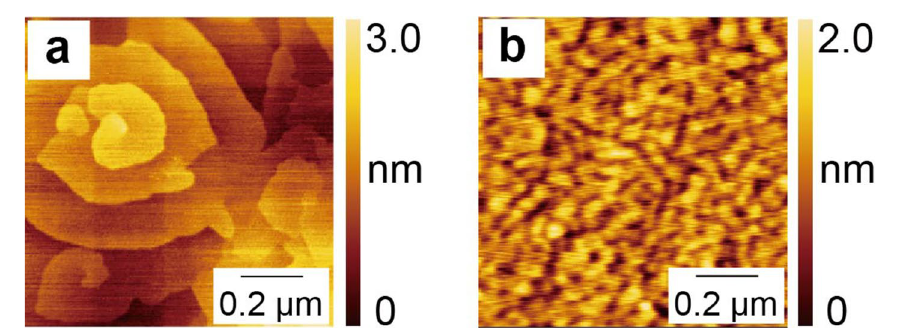
Figure 4. Surface morphology of the Ti 2 O 3 films. AFM images of the ( a ) HT- and ( b ) LT-Ti 2 O 3